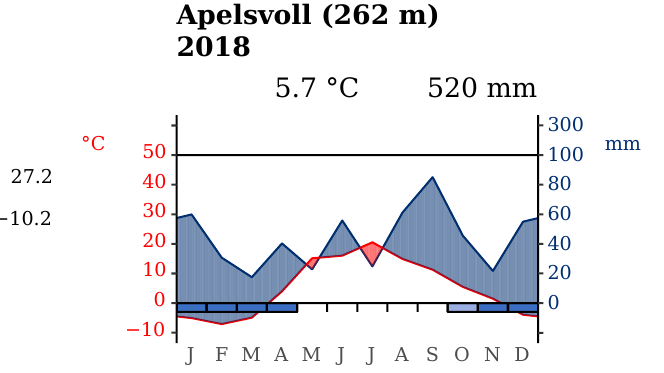
Figure 2. Walter and Lieth diagram of weather conditions in the year of the experiment. The red and blue lines depict mean temperatures and precipitation sums, and red and blue areas correspond to dry and humid periods. The values on the left are temperature extremes for the whole year, and the boxes along the abscissa mark months with frost risk. Note the period of drought signaled in May, when the crop was sown. Source: Agrometeorology Norway (https://lmt.nibio.no, accessed on 25 August